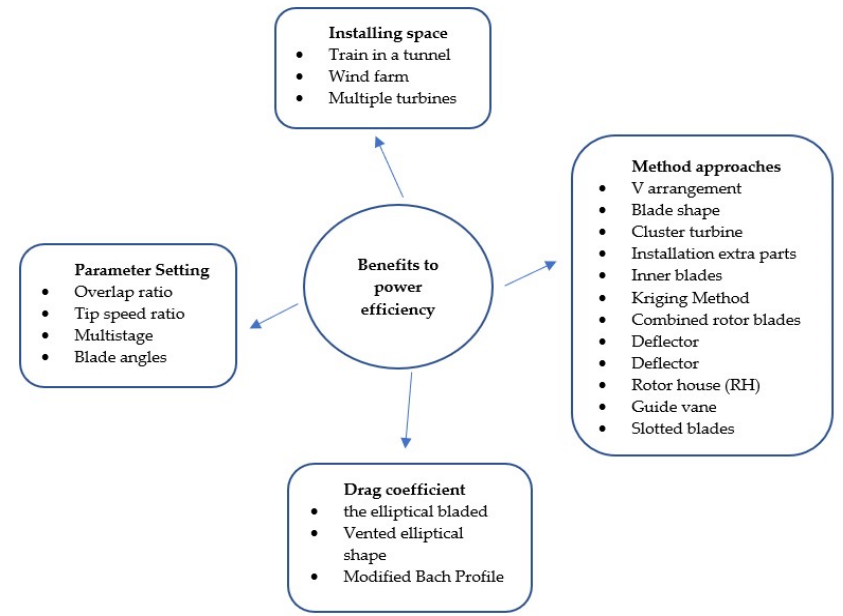
Figure 1. Benefit categories for Savonius wind turbine efficiency.